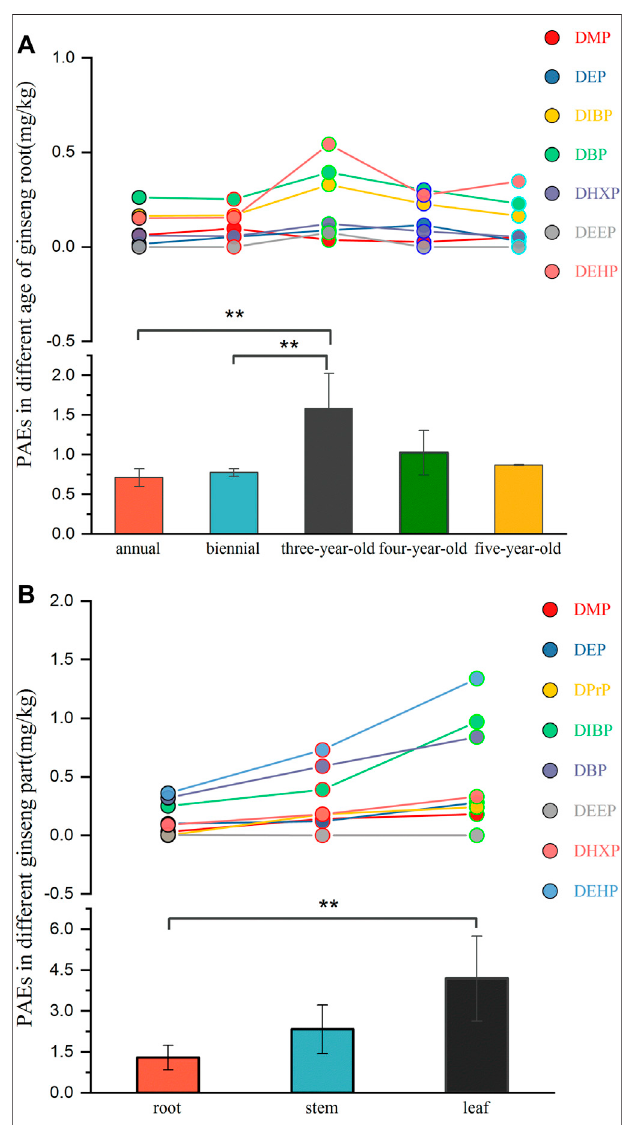
FIGURE 4 | Concentrations and distribution of PAEs in ginseng roots under fi ve cultivation ages (annual, biennial, 3-year-old, 4-year-old, and 5- year-old) (A) and ginseng tissues (root, stem, and leaf) (B) . ** in the picture indicates signi fi cant differences ( p < 0.05).